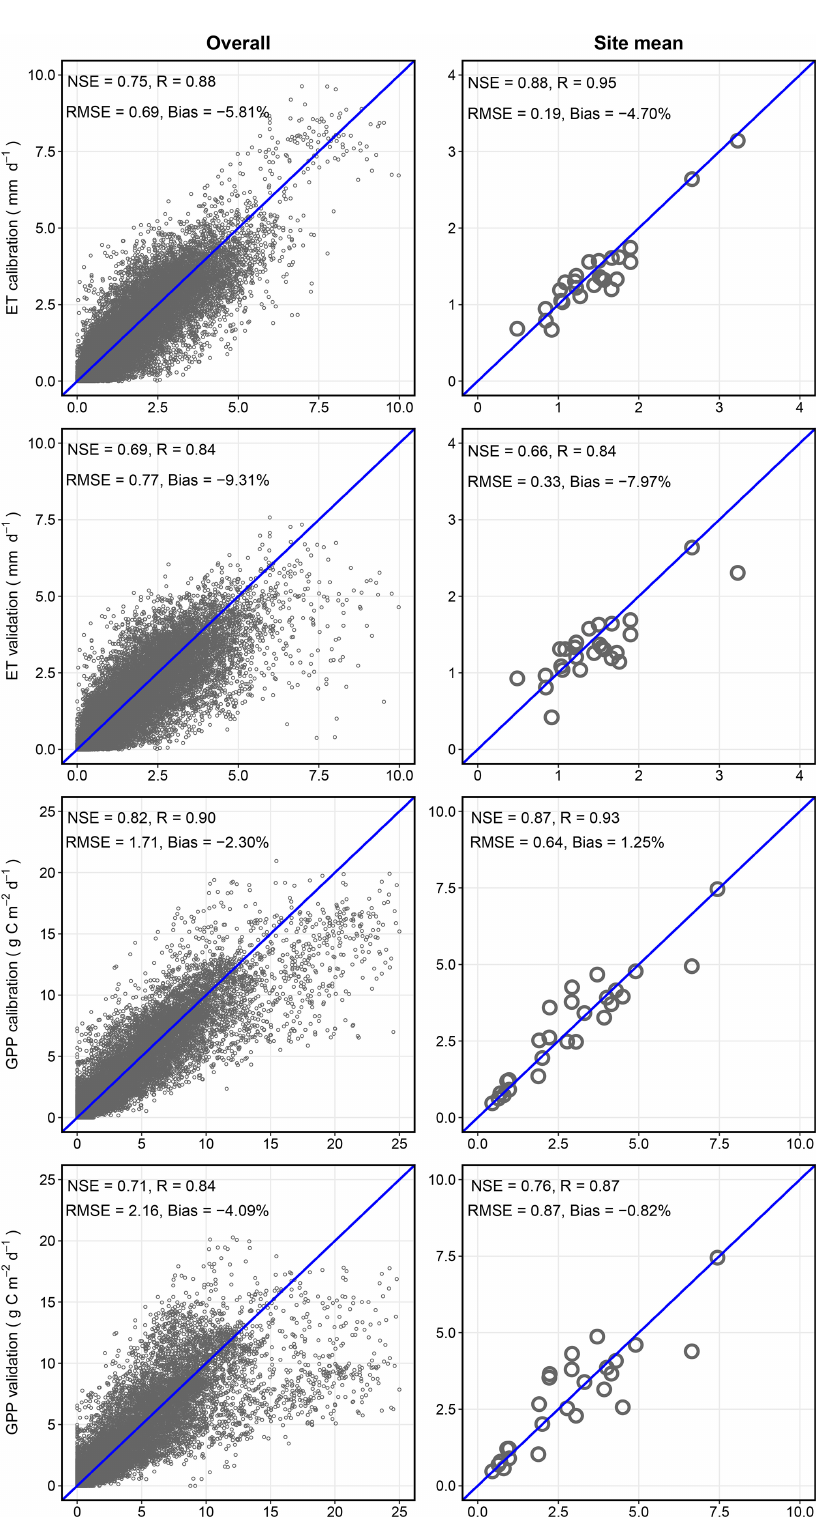
Figure 3. Scatter plots between the observed ET and GPP against PML-V2(China) simulations in the calibration and cross-validation modes: daily comparisons in the left panels and site mean comparisons in the right